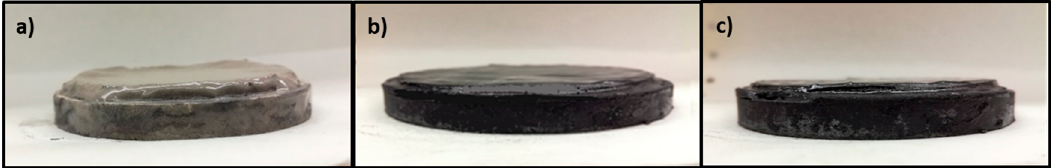
Figure 11. Effect of ilmenite on filtration performance of drilling fluid (250 °F).